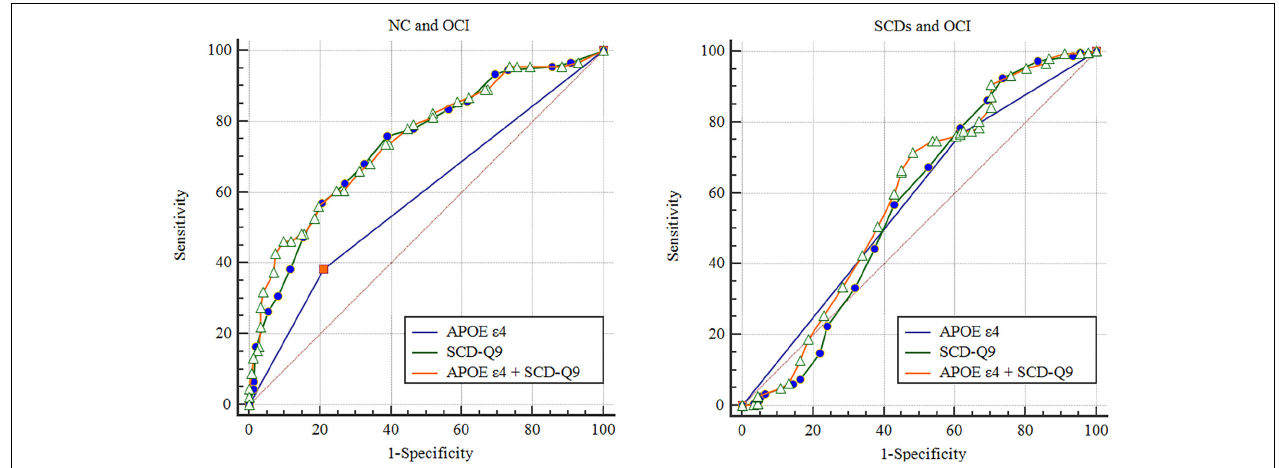
Frontiers in Neuroscience |